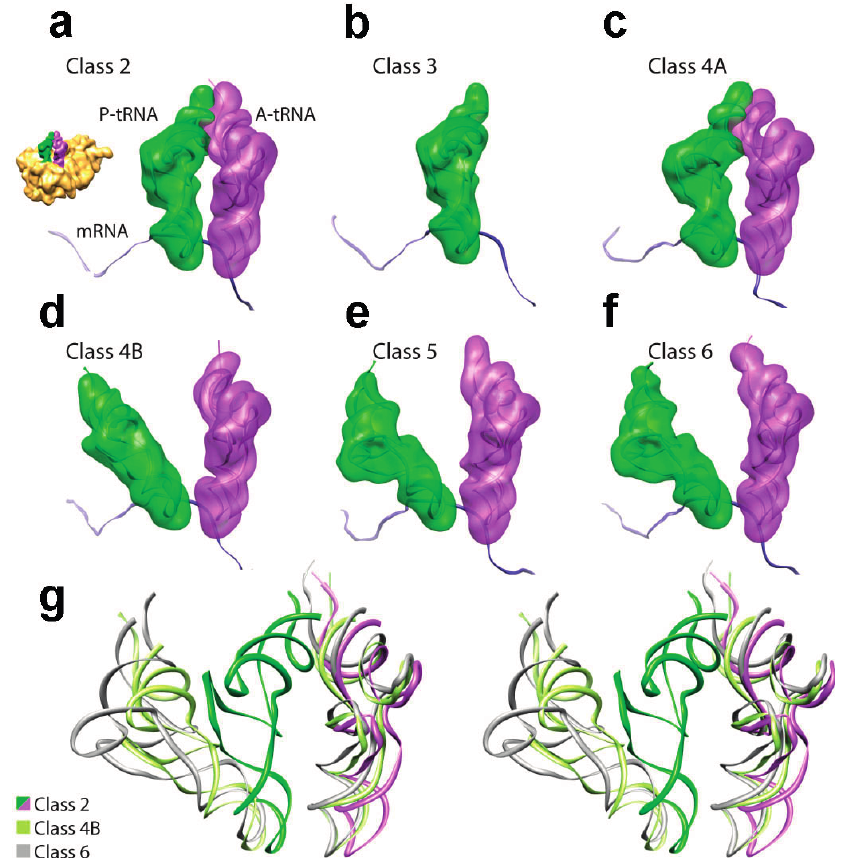
Figure 7. Comparison of translocation intermediates obtained by cryoEM and particle sorting. ( a – f ) Maximum likelihood methods were applied to a dataset of pre-translocational complexes in the absence of EF-G, obtaining an ensemble of substates that encompass a large conformational space. Out of the initial six classes, one subset (class 4) was further subdivided due to residual heterogeneity (class 1 is not shown as it was deemed to be artifactual due to bias in particle orientations). Class 2 ( a ) and class 4A ( c ) correspond to the classic A/A and P/P tRNA configuration, while class 3 ( b ) corresponds to ribosomes bearing a single tRNA configuration (P/P). Classes 5 ( e ) and 6 ( f ) are similar to each other, and to the previously characterized A/P and P/E hybrid configurations [160,161]. Class 4B ( d ) represents a new intermediate in which the P-site tRNA’s elbow is halfway through its transition from classic to hybrid state, a configuration that is coupled to an intermediate intersubunit rotation and L1 stalk movement; ( g ) Stereo-view of the superposition of A- and P-site tRNAs from class 2 (classic state tRNAs, in magenta and green), class 4B (new intermediates, in olive) and class 6 (hybrid state tRNAs, in gray), aligned with respect to the 70S ribosomes. (Figure adapted from [168], Copyright 2012 Proc. Natl. Acad. Sci.